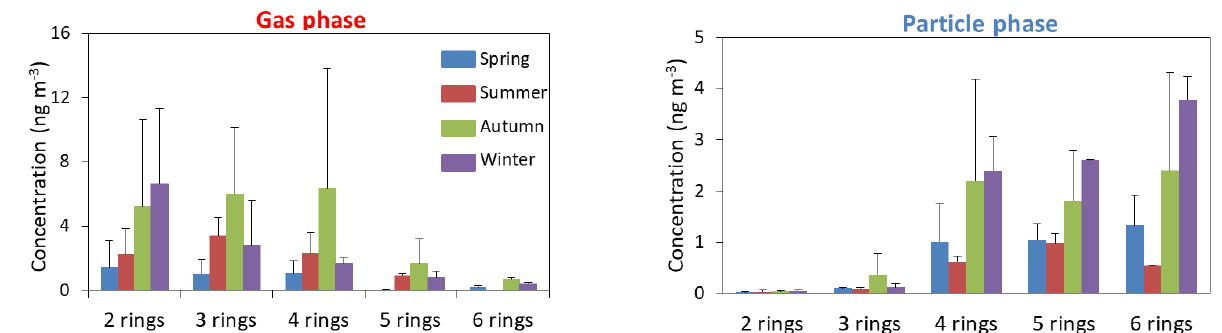
Figure 3. Concentration of PAHs with different numbers of rings in the particle and gas phases for four seasons.